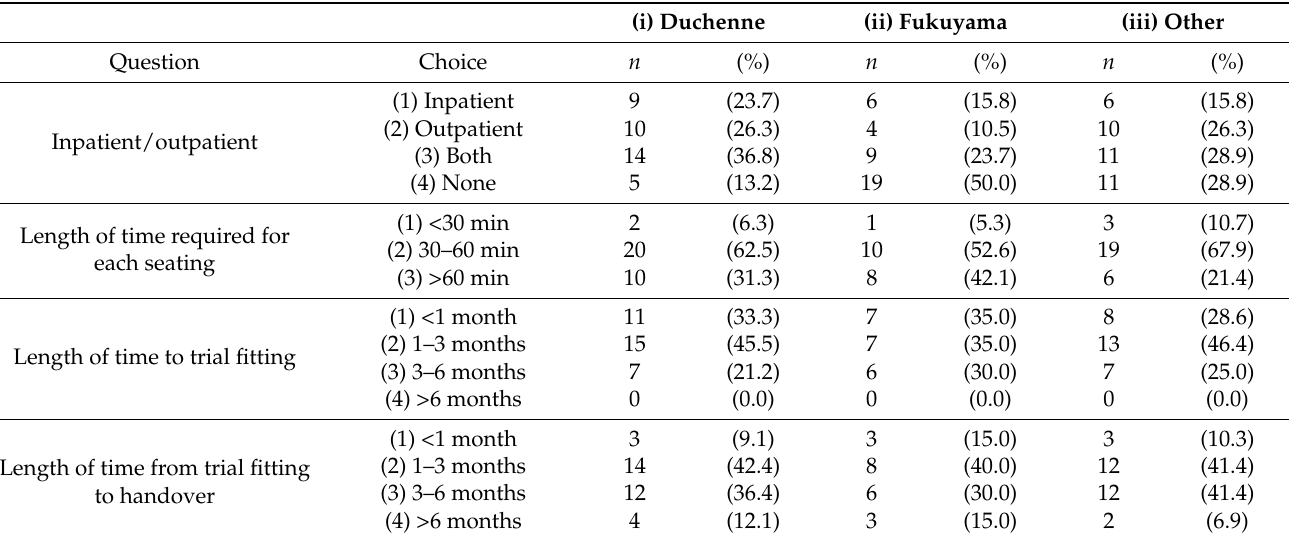
Table 3. Seating for patients with different types of MD ( n = 38).